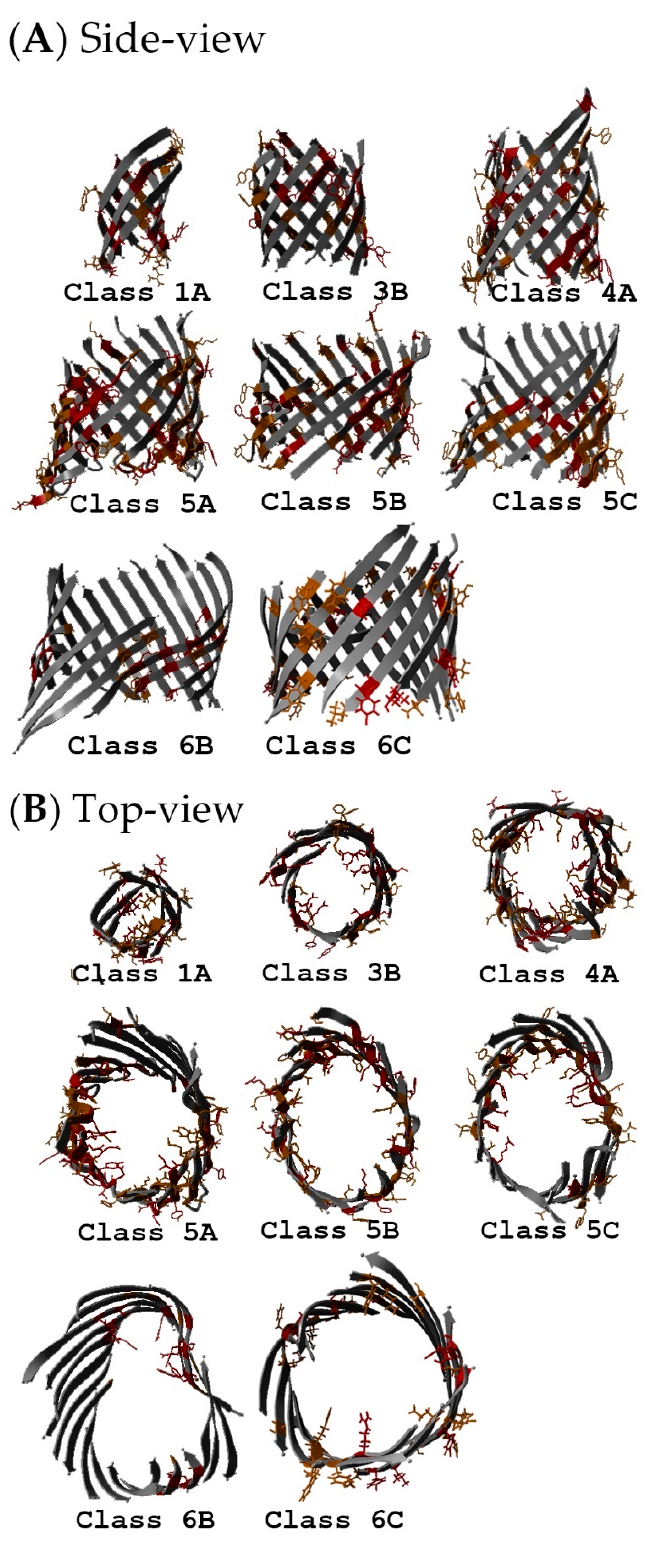
Figure 7. Conserved non-specific porin and specific diffusion channel residues. ( A ) Side view and ( B ) top view of conserved residues (Boxes 11, 12, and 22). Only the monomeric state is shown for all subclasses. Loops and turns are deleted to visualize the protein core. These results can be downloaded and viewed in 3D from the associated websites (YASARA scene files; see the Supplementary Materials).